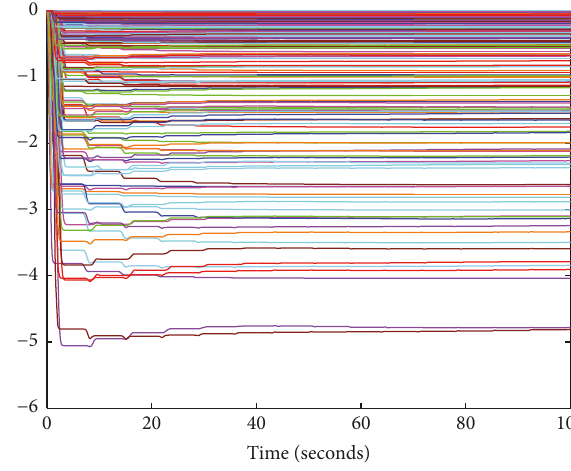
Figure 7: Partial parameter convergence of